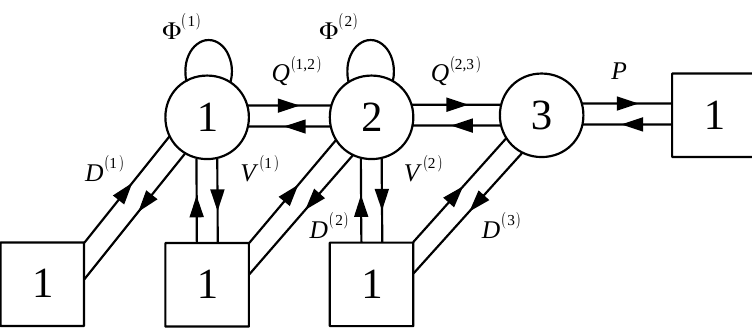
Figure 11 . Quiver diagram of the G [U(3)] theory, which is the starting point of the piecewise derivation of the recombination